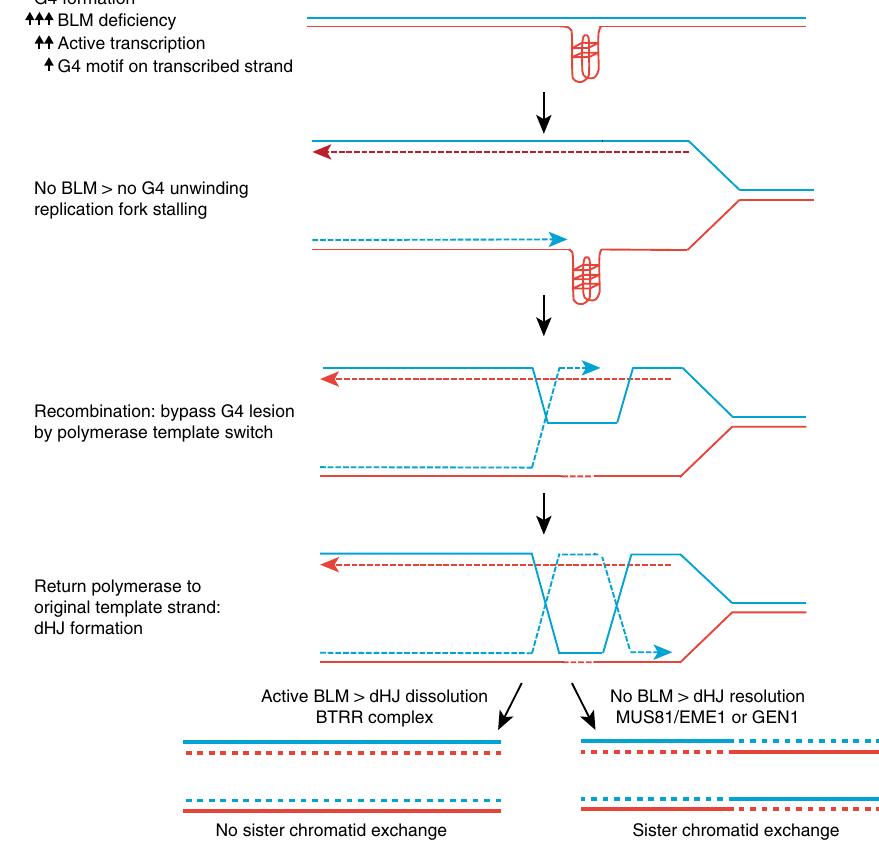
Fig. 6 BLM helicase suppresses recombination at G4 structures. Model for the role of BLM in suppressing recombination at sites of G4 structures. G4 structures are more likely to form or persist in the absence of unwinding by BLM. They can form at G4 motifs throughout the genome, but formation is promoted by transcription, especially if the G4 motif is present on the transcribed strand. In BLM pro fi cient cells, BLM unwinds the G4 structure before the genomic region is replicated, ensuring smooth DNA replication. In the absence of BLM, G4 structures are not unwound, preventing replication fork progression, and leading to replication fork stalling. Stalled forks require homologous recombination (HR)-mediated repair, leading to formation of a double Holliday junction (dHJ). In the absence of BLM, dHJs cannot be dissolved by the BLM-TOPO3 α -RMI1-RMI2 (BTRR) complex and must be resolved by MUS81-EME1 or GEN1, leading to frequent formation of sister chromatid exchanges event, and potentially loss of heterozygosity, and other types of motifs, which is signi fi cantly different ( p < 0.01) from the expected 50% if there was no causal relationship between G4 motifs and SCEs (Fig. 4h). No signi fi cant deviation from the − expected 50/50 ratio was detected in the WT or the Blm +/ cell lines. Combined, these results con fi rm that SCEs mainly form at G4 structures in absence of Blm and especially at those G4s present in the transcribed strands of active genes.